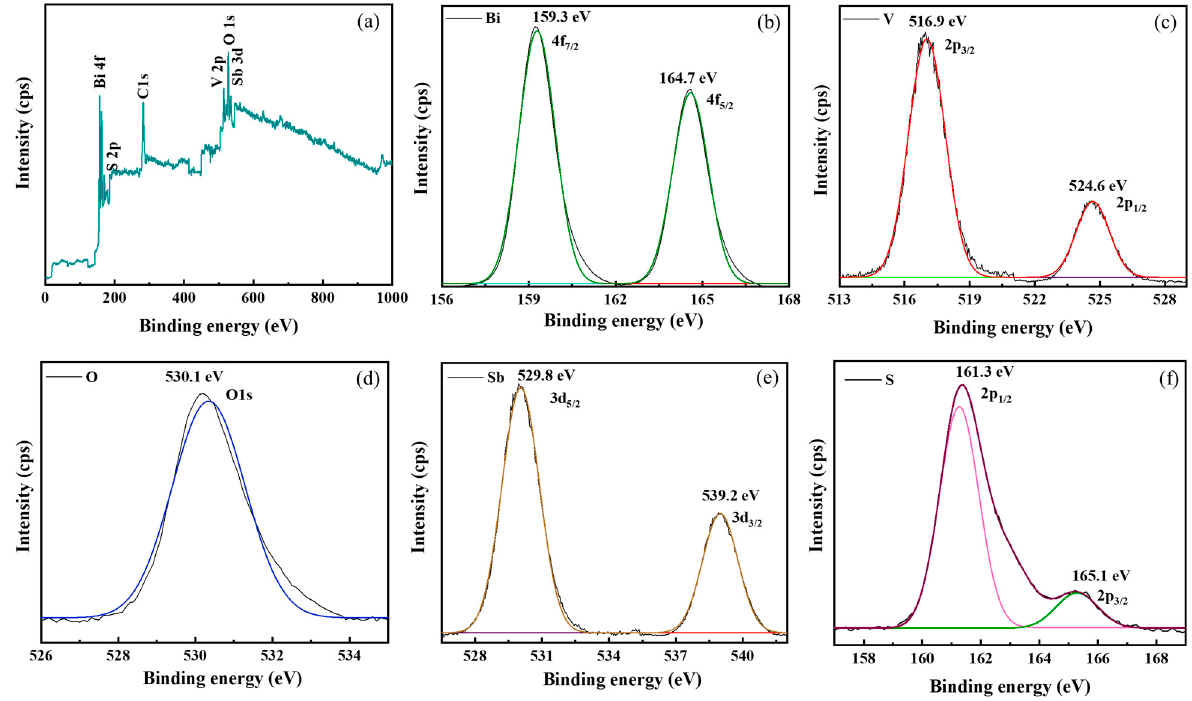
Figure 1. XPS spectrum of 13BVSBS photocatalyst: ( a ) survey spectra, ( b ) Bi 4f, ( c ) V 2p, ( d ) O 1s, ( e ) Sb 3d, and ( f ) S 2p.